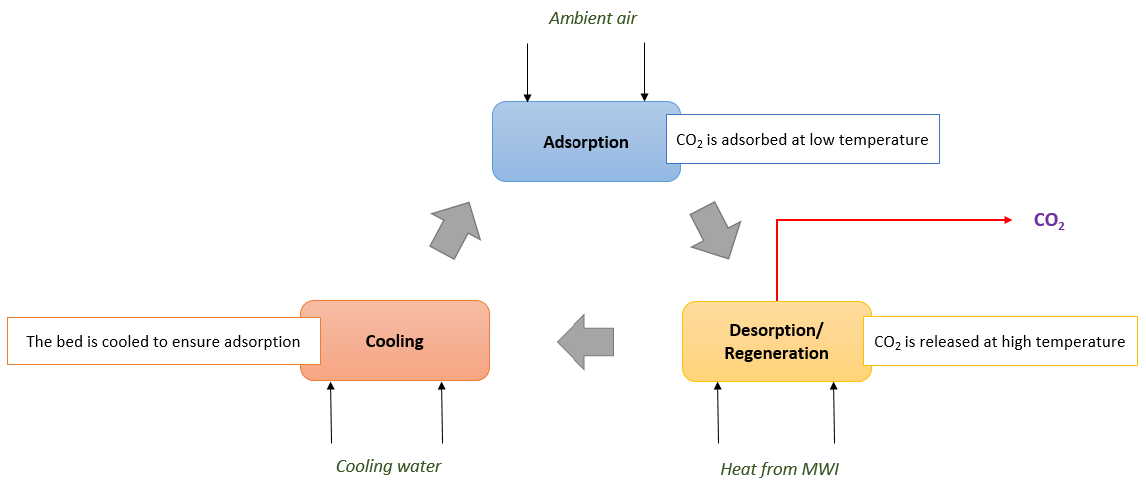
Figure 1 . Operating principle of TSA process . Figure 1. Operating principle of TSA